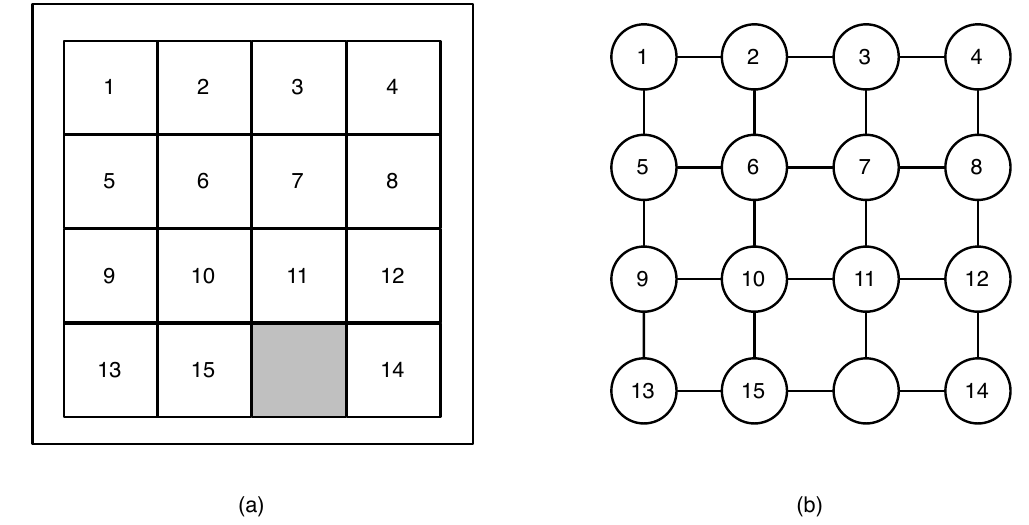
Figure 1. ( a ) one arrangement of tiles of the 15-puzzle; ( b ) the puzzle represented as a